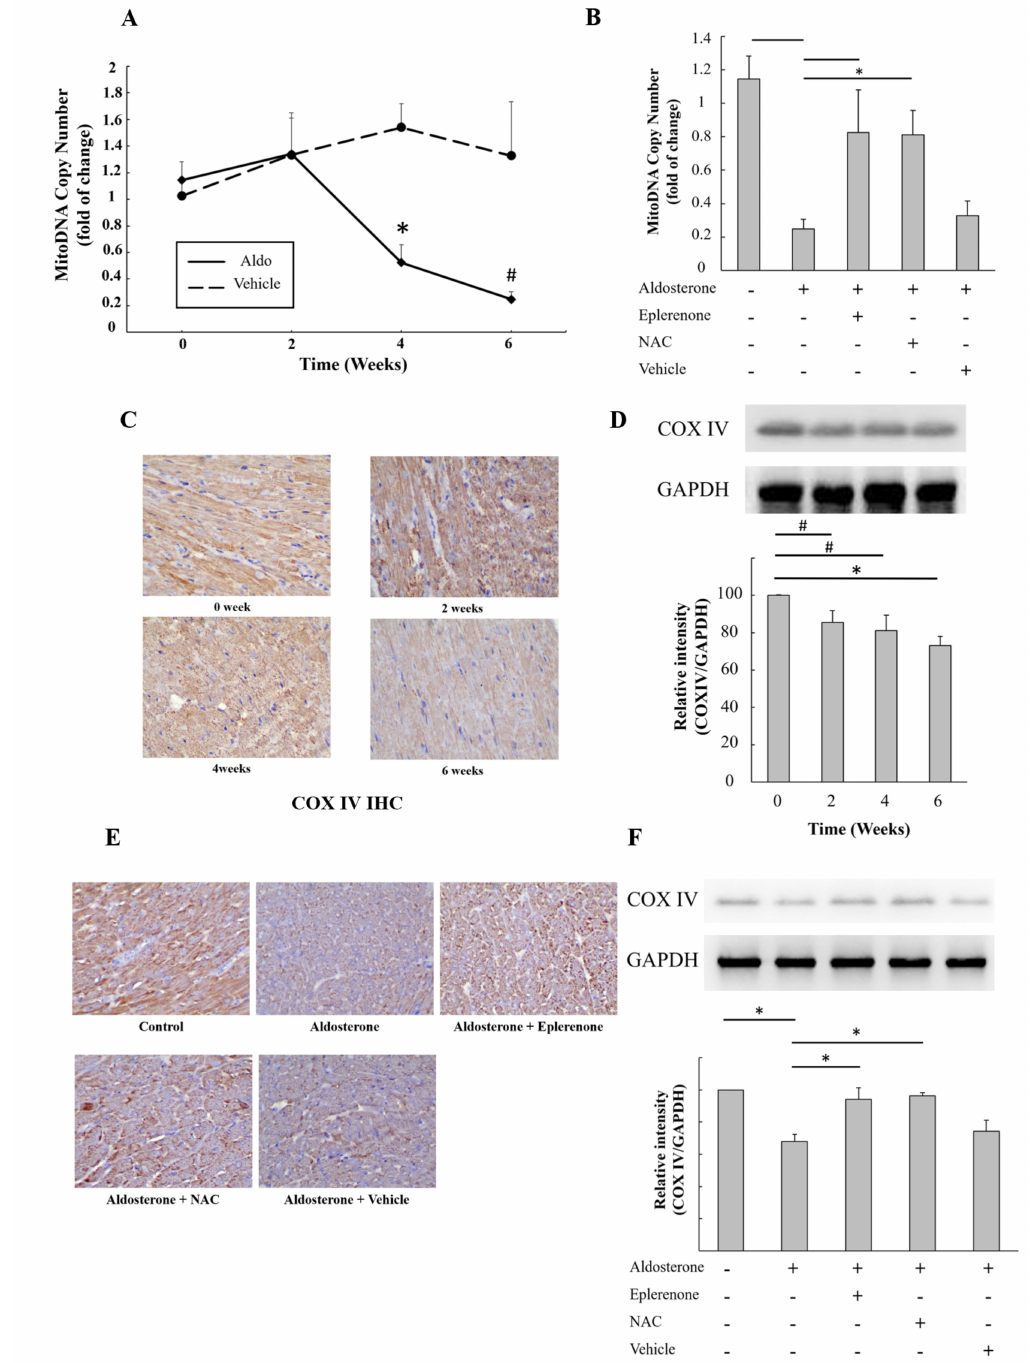
Figure 4. In vivo effect of aldosterone on mitochondrial DNA and COX IV protein in ICR mice. ( A ) Time course effect of aldosterone on heart tissue mitochondrial DNA in the aldosterone-infused ICR mice and controls. ( B ) Effect of an MR antagonist (eplerenone) and antioxidant (NAC, N–acetyl–L–cysteine) on cardiac mitochondrial DNA. ( C ) Immunohisto- chemical staining of cardiac mitochondrial COX IV protein after 0, 2, 4 and 6 weeks of aldosterone infusion; magnification × 400. ( D ) Western blot of cardiac COX IV protein and the corresponding quantitative results after 0, 2, 4 and 6 weeks of aldosterone infusion. ( E ) Immunohistochemical staining of cardiac mitochondrial COX IV protein after 6 weeks of aldosterone infusion in control and aldosterone-infused ICR mice treated with eplerenone, NAC and vehicle; magnification × 400. ( F ) Western blot of cardiac COX IV protein and the corresponding quantitative results after 6 weeks of aldosterone infusion in control and aldosterone-infused ICR mice treated with eplerenone, NAC and vehicle. # p < 0.05 and * p < 0.01, compared between the two groups indicated by the line